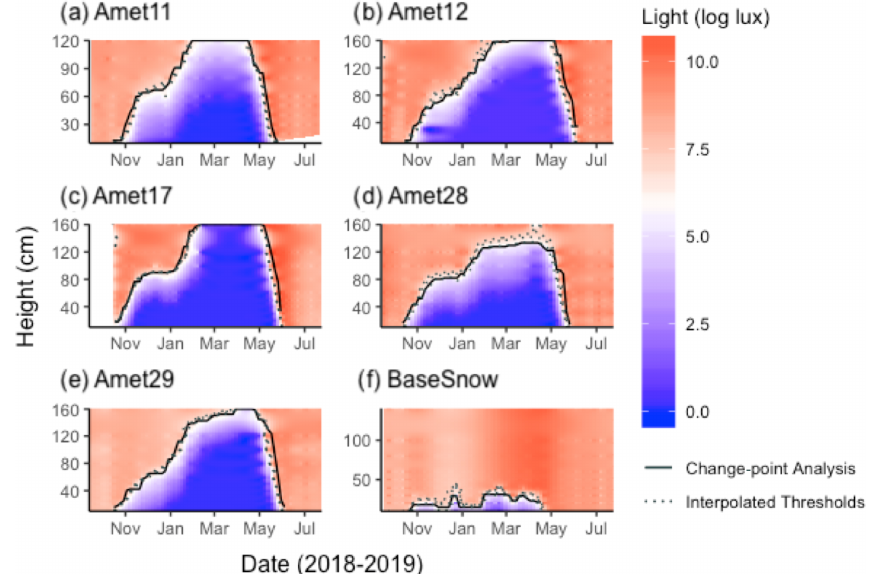
Figure 7. Interpolated lux measurements presented as an X – Y – Z plot on a log-scale for each SCLT measurement site including (a) Amet11, (b) Amet12, (c) Amet17, (d) Amet28, (e) Amet29 and (f) BaseSnow. Estimated snow depths are presented for change-point analysis (black) and the mean of the no-snow thresholds (contour method;